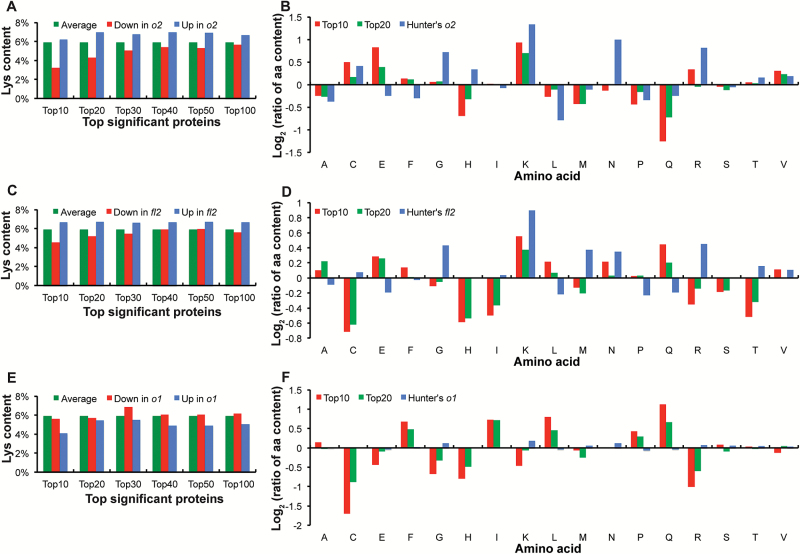
Amino acid content analysis in non-zein proteins for o2, fl2, and o1 compared with WT. (A, C, E). Lysine (K) content was calculated for the top significant increased and decreased proteins in o2 (A), fl2 (C), and o1 (E), compared with WT. The average lysine content of the most increased (Up, blue) and decreased (Down, red) proteins, and all proteins (Average, green) were compared from the top 10 to the top 100. (B, D, F) The amino acid content data (blue, in percentage protein, w/w) in o2 (B), fl2 (D), and o1 (F) from Hunter (2002). Amino acid abbreviations are shown in alphabetical order, and Glx from Hunter (2002) was placed on both Glu (E) and Gln (Q).